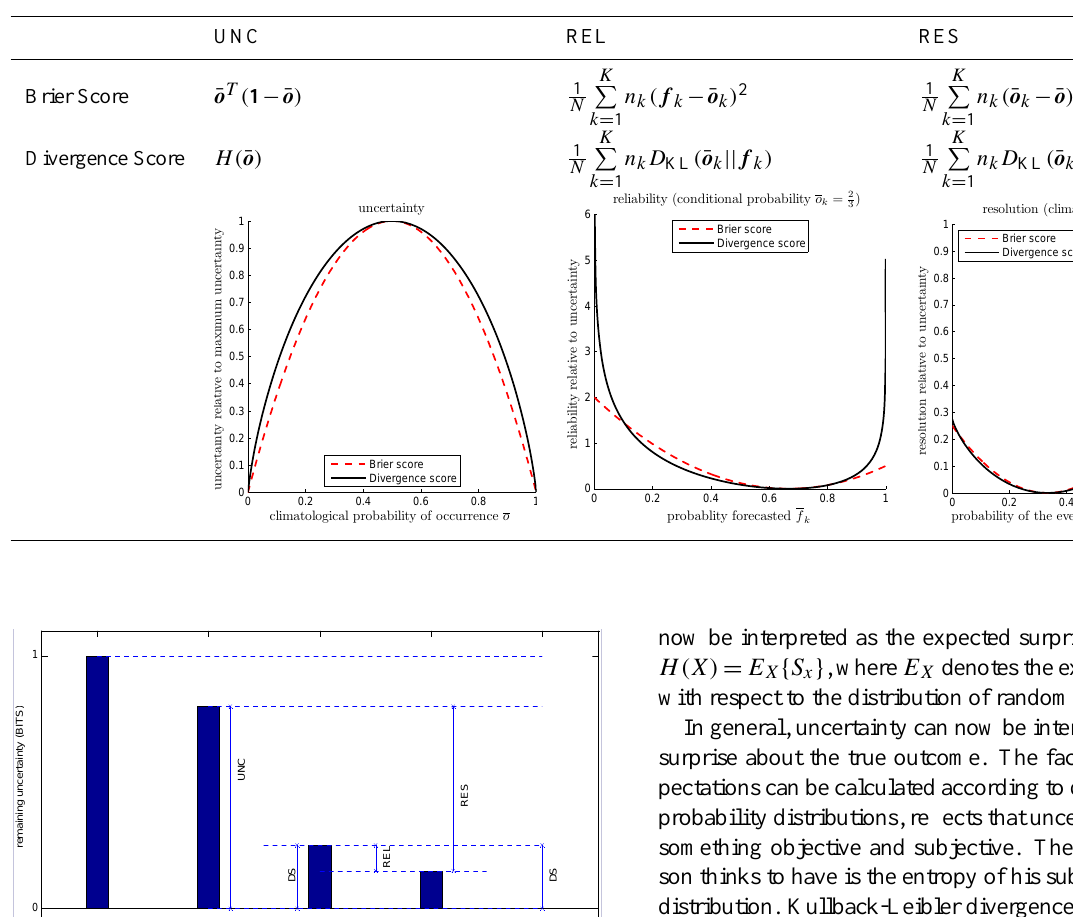
Table 1. Comparison between the expressions and behaviour of the decompositions of the Brier score and the divergence score for the case of binary events.